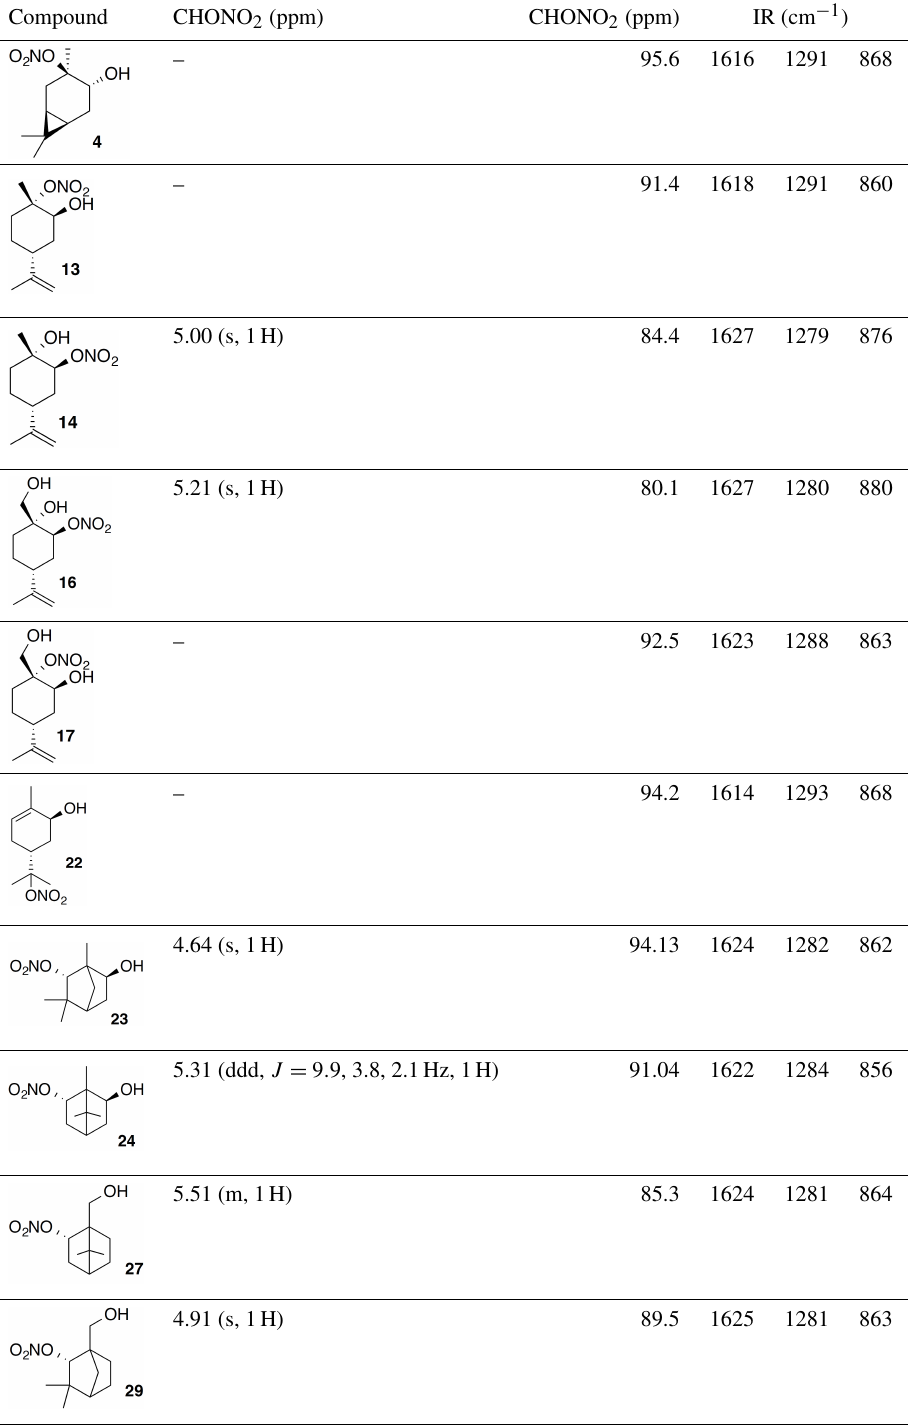
Table 1. Collated 1 H and 13 C NMR data with IR absorbances for nitrate